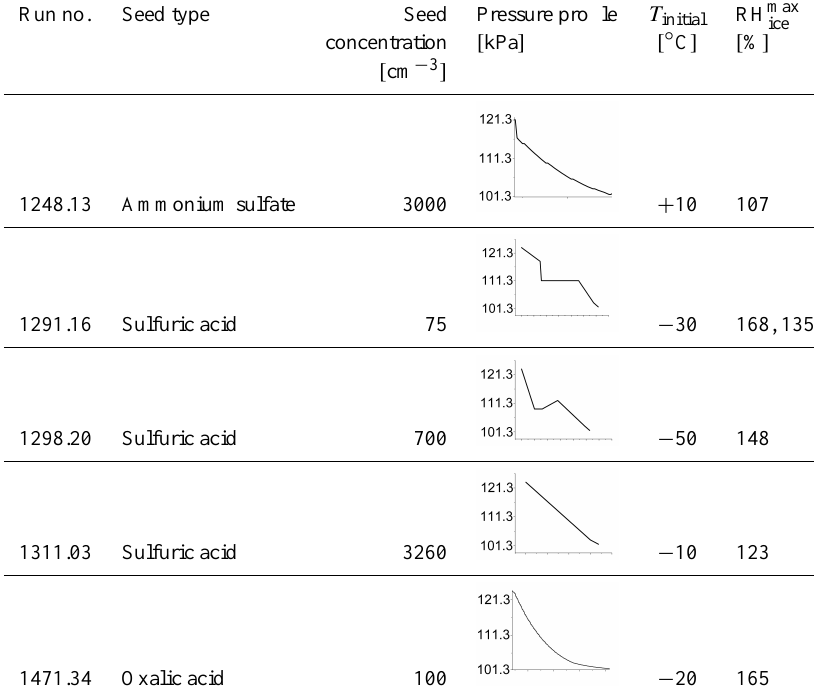
Table 1. Experimental parameters of the expansion runs presented in this paper. Pressure profile x axis is of the order of several minutes. Run